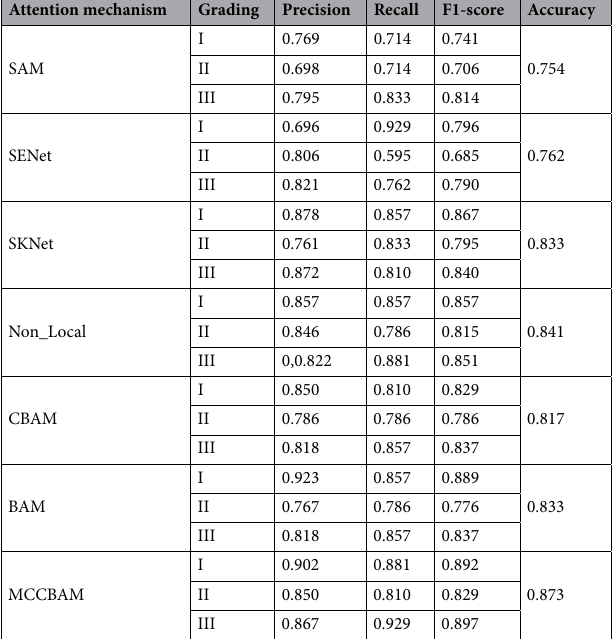
Table 5. Comparison of MCCBAM with other attention mechanisms.